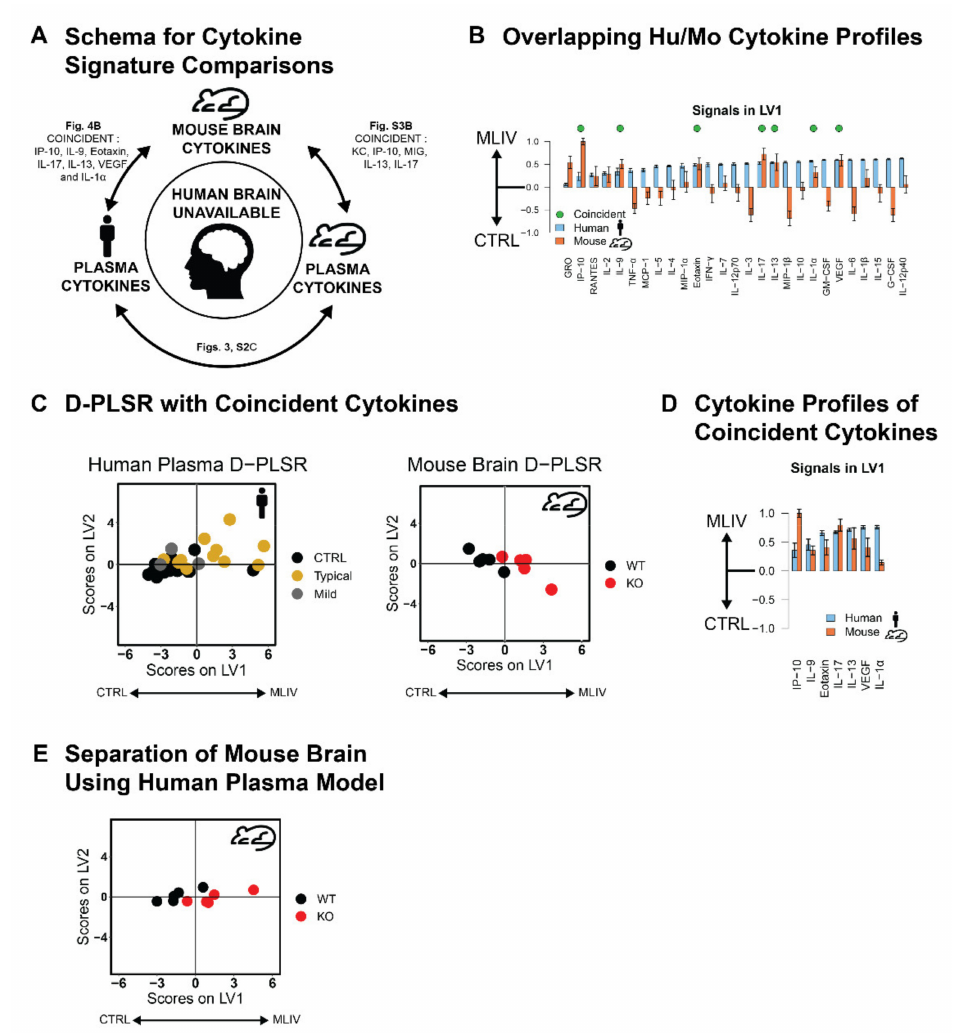
Figure 4. Coincident cytokine signature distinguishes human MLIV plasma and mouse brain samples. ( A ) Concept for identifying potential cytokines that may predict human MLIV brain condition based on cytokines measured in the human and mouse plasma, as well as on cytokine overlap between mouse brain and plasma. ( B ) LV1 cytokine profiles distinguishing mouse brain and human plasma generated based on 26 overlapping cytokines in human and mouse datasets. Of these, 7 cytokines were coincident in directionality to separate human plasma and mouse brain MLIV samples from controls (mean ± SD in a LKOCV with K = 3 for human samples, K = 1 for mouse). ( C ) D- PLSR analysis with 7 coincident cytokines separated both human plasma and mouse brain samples from controls along LV1, suggesting that this reduced cytokine signature is capable of separating control and MLIV samples from both human plasma and mouse brain samples. N = 18 CTRL, 18 MLIV (15 typical and 3 mild) for human samples and N = 5 WT, 5 Mcoln1 − / − for mouse samples. ( D ) Reduced 7 cytokine LV1 profiles distinguishing MLIV and control cases for human plasma and mouse brain. ( E ) D-PLSR model generated based on 7 cytokines from human plasma separated wild-type mice to the left and KO mice to the right based on brain cytokine